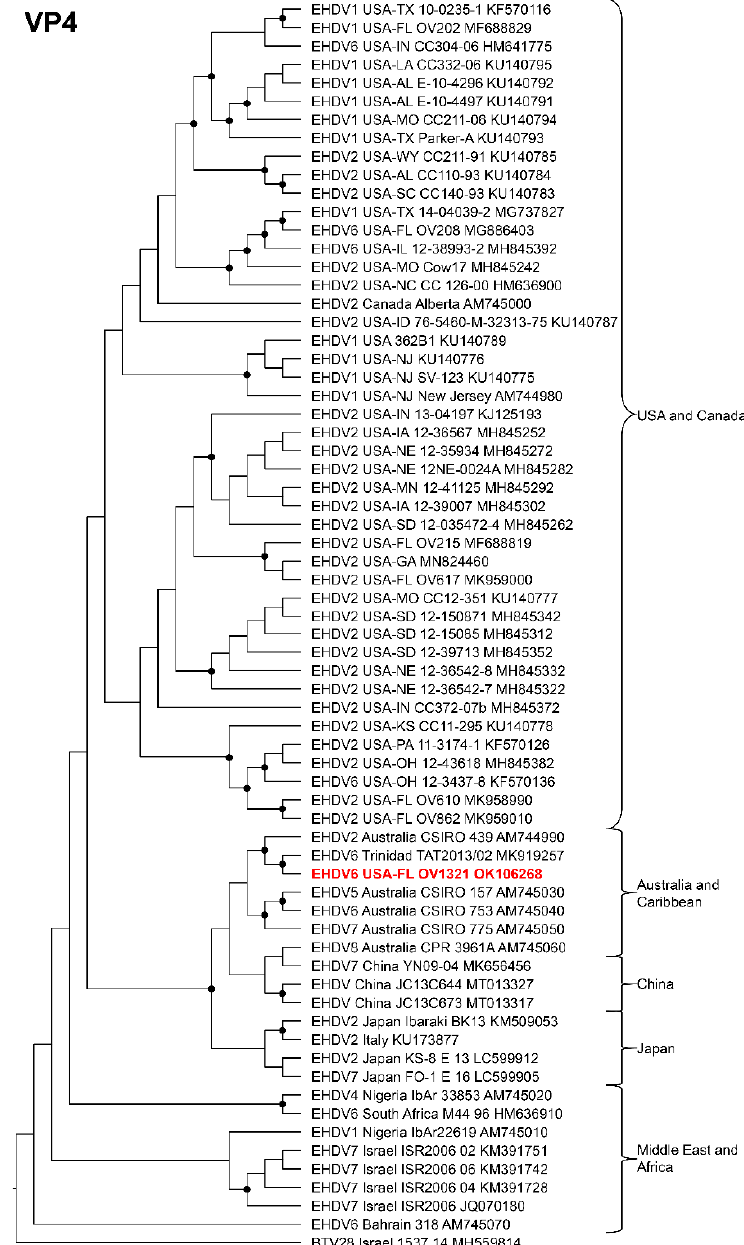
Figure 5. Maximum Likelihood cladogram depicting the relationships of the U.S. novel reassortant EHDV-6 strain isolated from a white-tailed deer (OV1321) to 67 other EHDV strains. The tree was generated from the nucleotide sequence alignment of the VP4 gene. The included EHDV and BTV strains are indicated by serotype, country, state (for U.S. strains), strain or isolate name, and GenBank accession no. Nodes with black circles are supported by bootstrap values ≥ 80%. The tree was rooted with the BTV-28 strain. Additional metadata for each virus in the tree are provided in Supplemental Table S1.